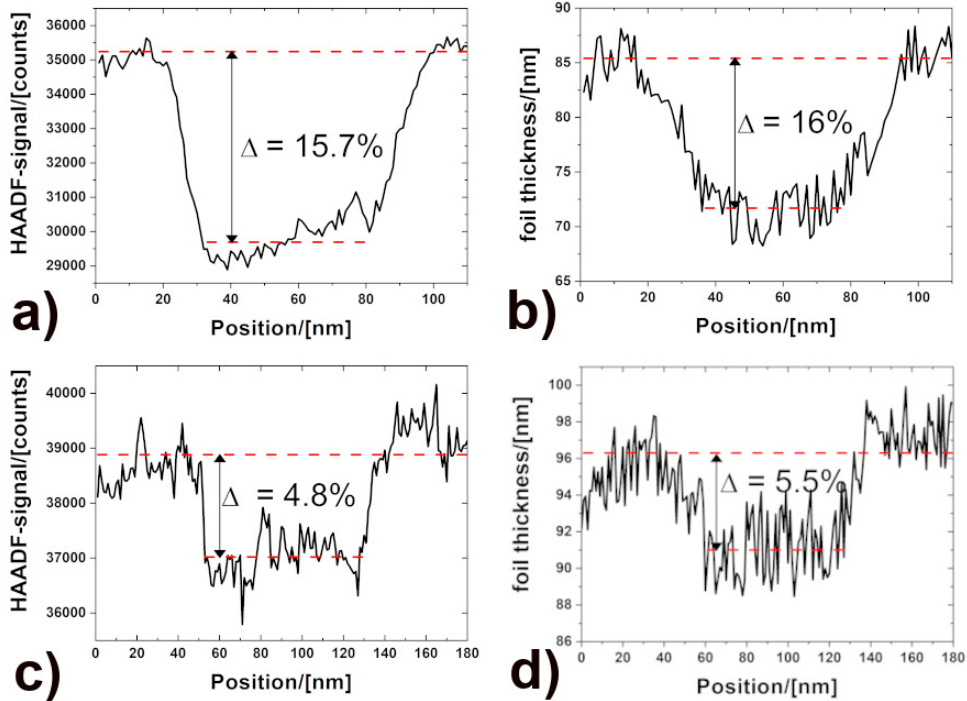
Figure 2. Corresponding line profiles as indicated in Figure 1b. ( a ) HAADF-STEM profile across the shear band corresponding to the shorter line, showing a reduction of 15.7% ± 1.9%. ( b ) Corresponding thickness profile showing a reduction of 16% ± 2.8%. ( c ) HAADF-STEM profile across the shear band corresponding to the longer line showing a drop of 4.8% ± 1.9%. ( d ) Corresponding thickness profile showing a reduction of 5.5% ± 2%.